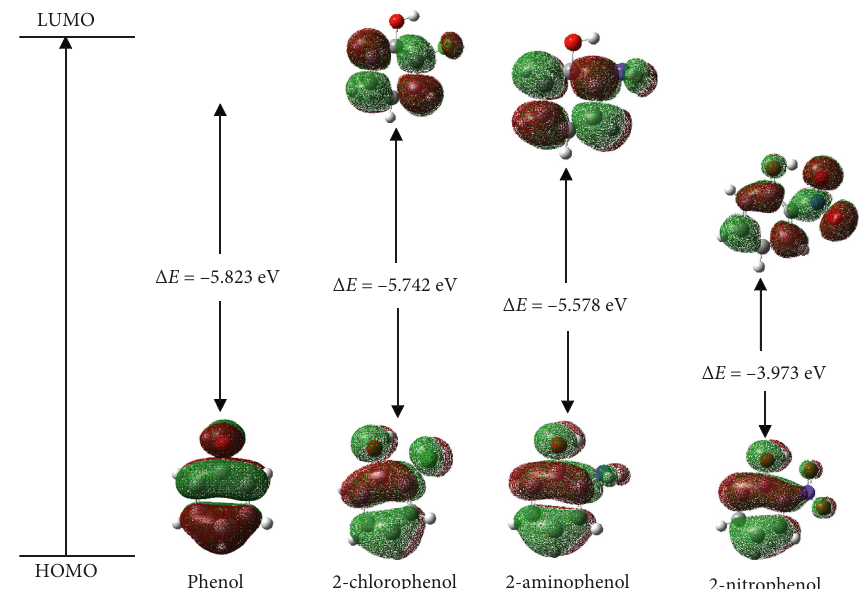
Figure 7: Frontier molecular orbitals of the phenols.